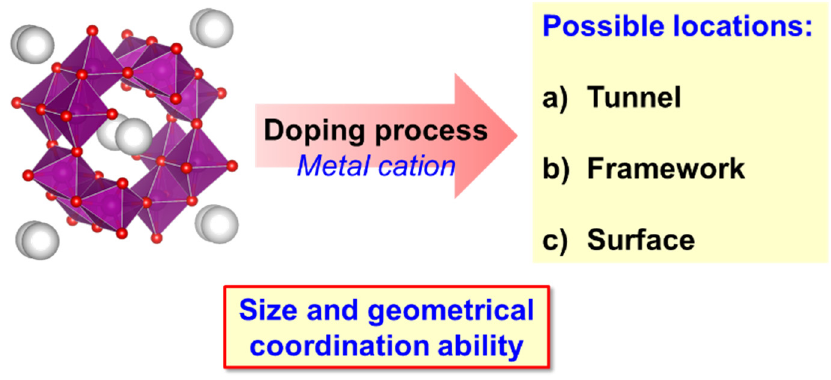
Figure 7. Scheme of the available positions for the cationic doping process on K–OMS–2